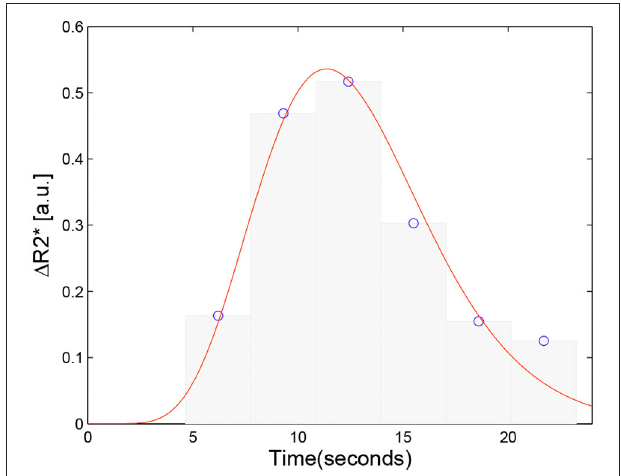
FIGURE 2 | Schematic of the proposed approach. The concentration curve 1 R 2 ∗ ( t ) is considered the frequency histogram of a random discrete sample X ( x 1 , x 2 , ... , x n ) with a gamma distribution f ( t = 1 R 2 ∗ ( t ) data. The original perfusion curve fitting problem then can be transformed to a gamma distribution fitting problem.